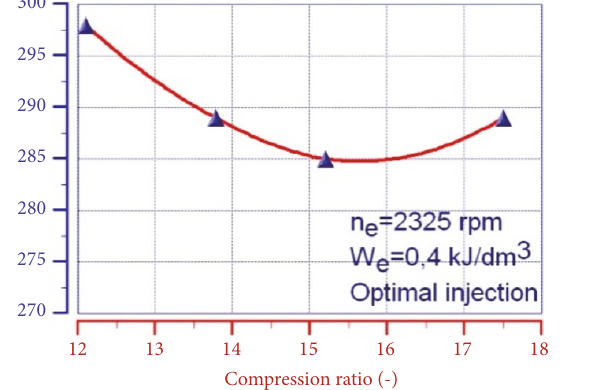
Figure 13. Generally, under very low loads, the (PM) emission is somewhat larger. The major reason for this is a